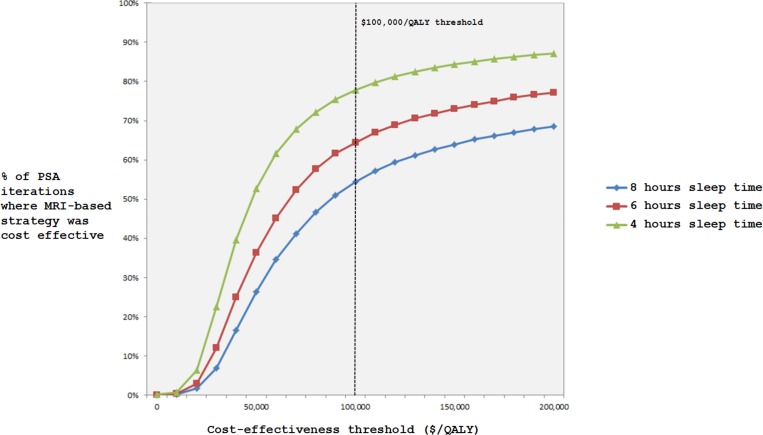
Cost-effectiveness acceptability curve from probabilistic sensitivity analysis.The probability of the MRI-based strategy and no treatment strategy being cost-effective plotted against the cost-effectiveness threshold. The probability of a strategy being cost-effective was based on the probabilistic sensitivity analysis, which incorporates the uncertainty of all model parameters.